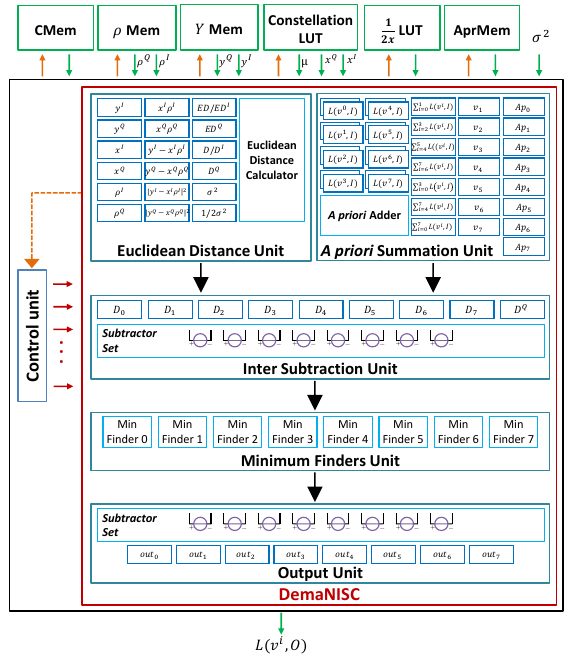
Figure 4. Proposed NISC-based demapper